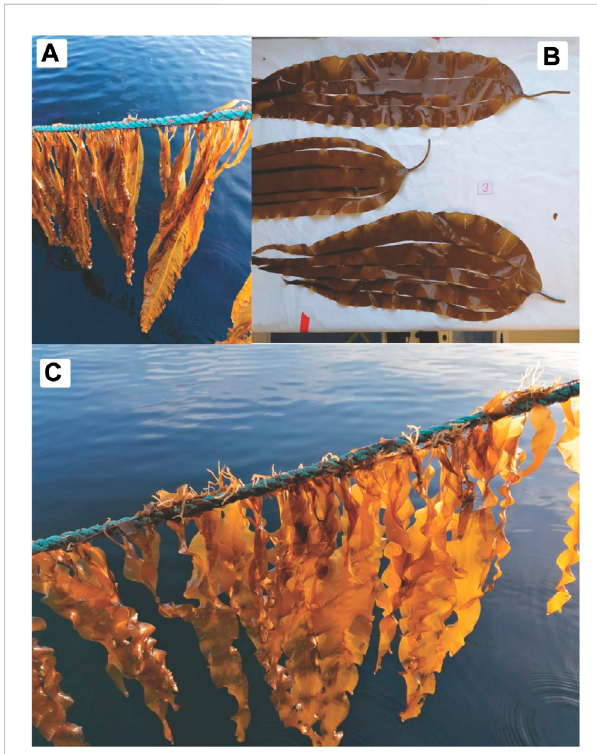
FIGURE 2 Depiction of (A) Alaria esculenta, (B) Laminaria digitata , and (C) Saccharina latissima during or after cultivation on standard rope systems in Oban, United Kingdom. Pictures provided by the Scottish Association for Marine Science